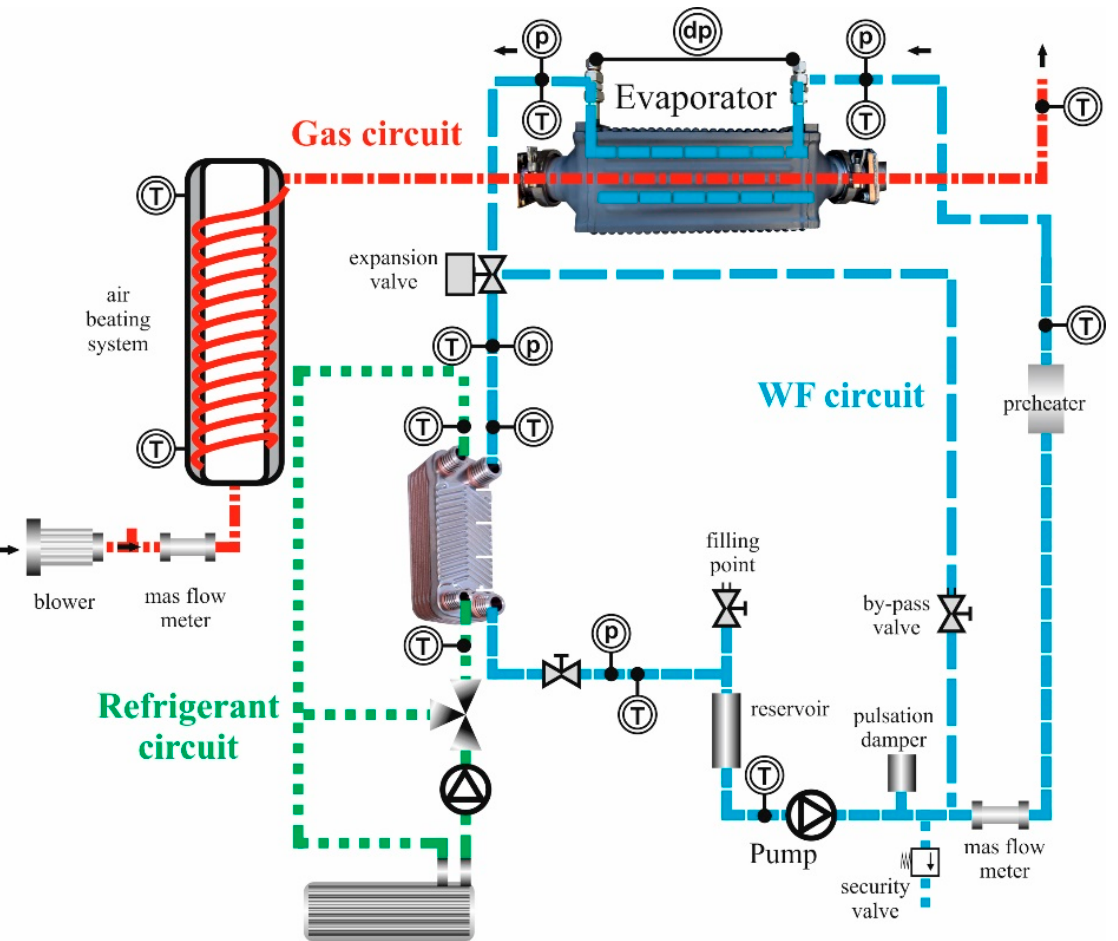
Figure 1. Schematic diagram of the test bench. The gas, WF, and water refrigerant circuits are represented in red, blue, and green, respectively. (T) Denotes temperature sensors, (p) absolute pressure sensors, and (dp) differential pressure sensors.